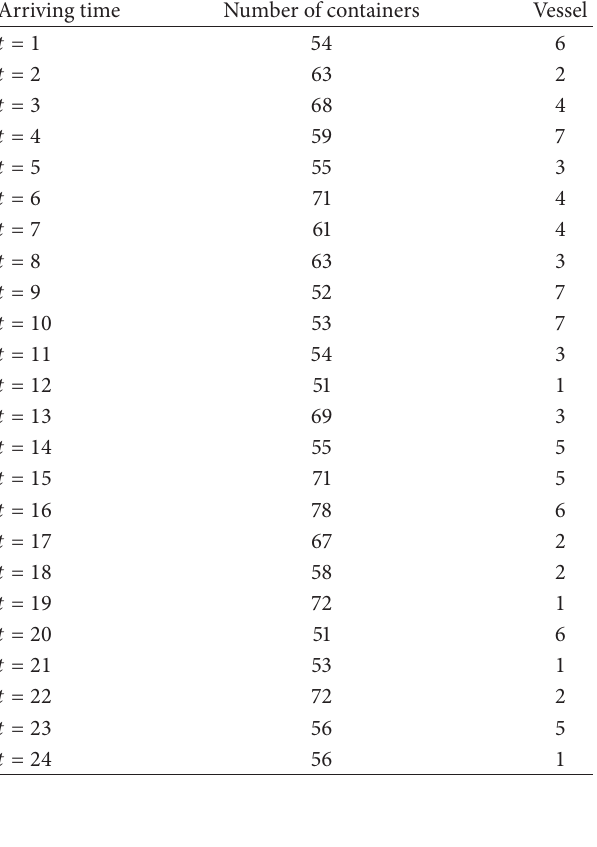
Table 2: The containers’ details from first train.